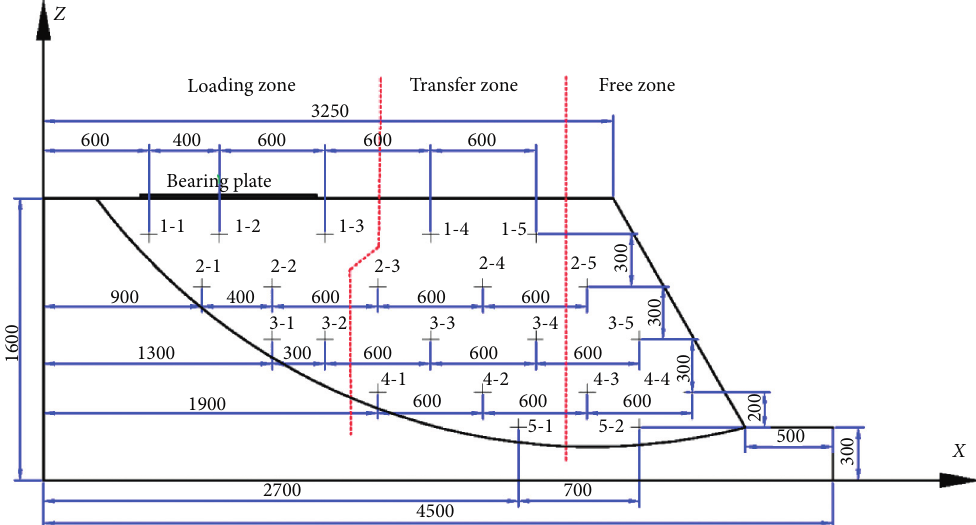
Figure 3: Plane layout of Earth pressure cells (unit: mm).